Question: Generate an informative caption for the figure above.
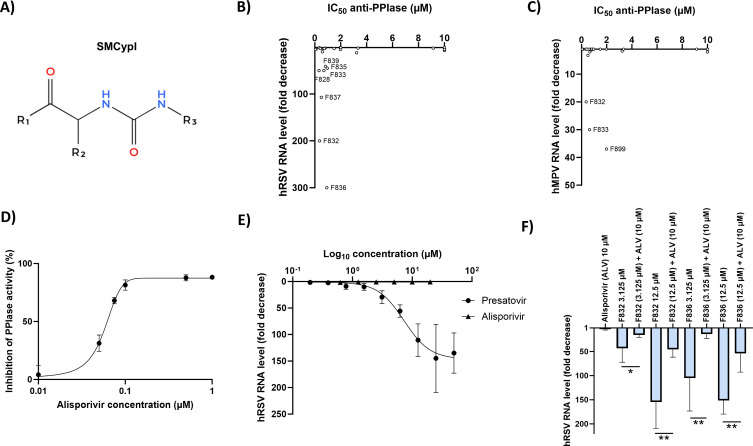
Answer: ( A ) General chemical structure of the SMCypIs with three variable moieties: R1, R2, and R3. ( B ) Relationship between antiviral activity against hRSV of 36 SMCypIs and their PPIase inhibitory activity, as measured by the IC 50 of enzyme activity with purified CypA. ( C ) Relationship between antiviral activity against hMPV of 36 SMCypIs and their PPIase inhibitory activity, as measured by the IC 50 of enzyme activity with purified CypA. ( D ) Dose-response inhibition of CypA PPIase activity by alisporivir. ( E ) Antiviral activity of presatovir and alisporivir against hRSV. ( F ) Antiviral activity of compounds F832 and F836 against hRSV at 3.125 and 12.5 µM, alone and in competition with alisporivir at 10 µM in HEp-2 cells. The data are presented as the mean ± standard deviation (SD) from at least two independent experiments. A two-tailed Student’s t -test was applied. * P -value < 0.05; ** P -value < 0.01.